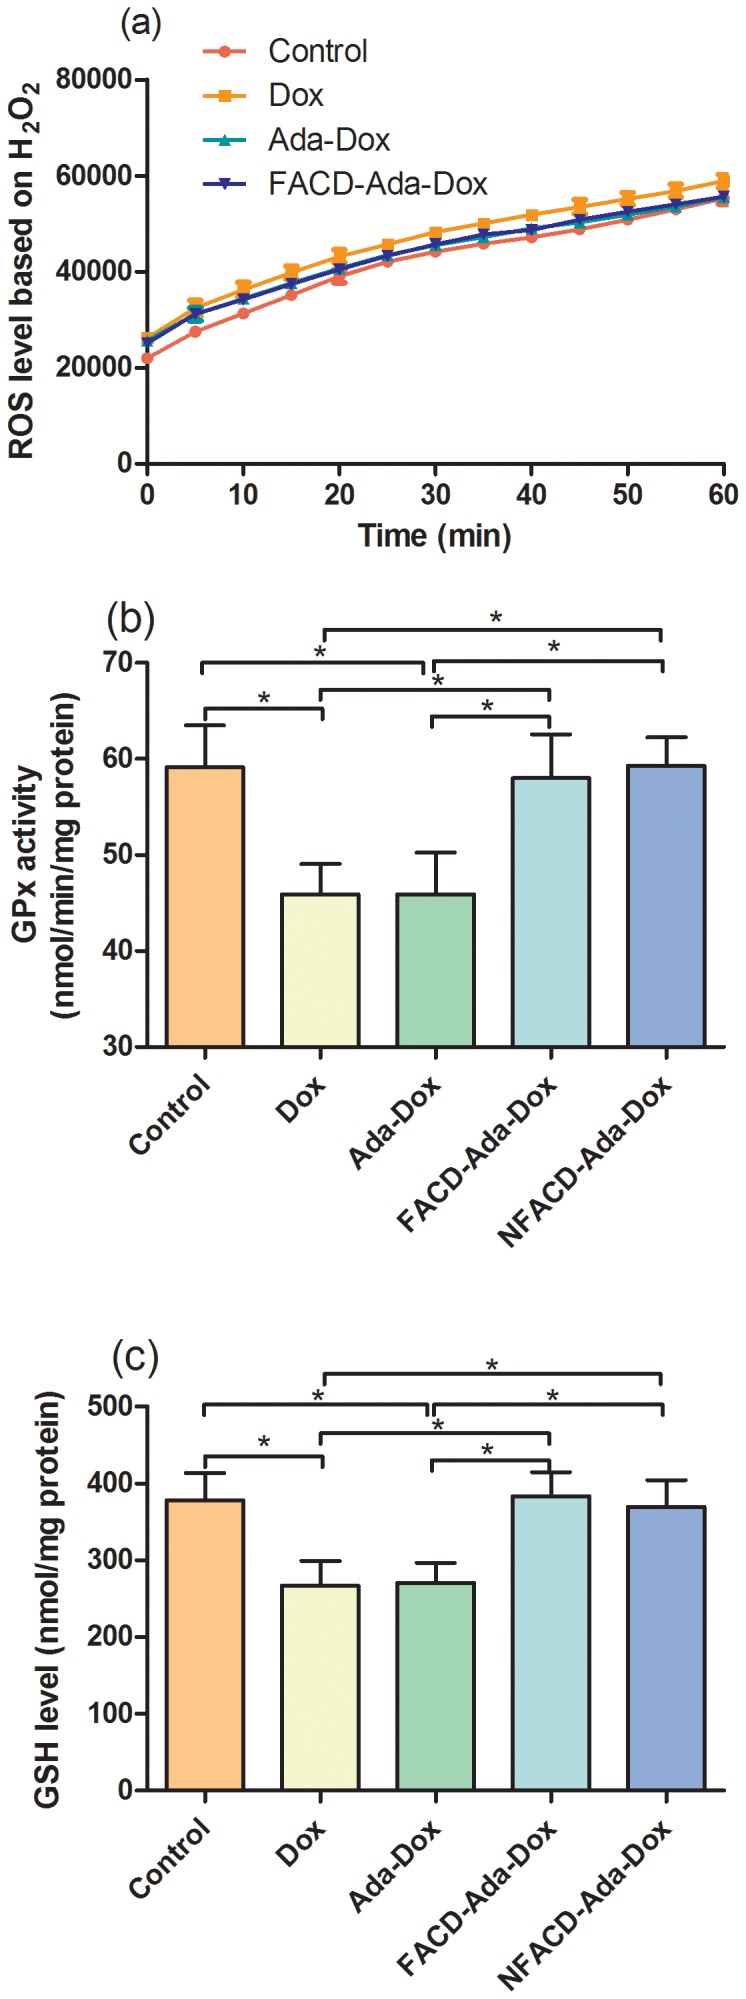
Determination of intraceullar ROS, GPx and GSH levels in mouse 3T3 cells.Plot a shows the level of intracellular ROS in 3T3 cells treated with Dox, Ada-Dox or FACD-Ada-Dox at 5.0 µM over 60 min at 37°C in the culture media. Cells were treated with CM-H2DCFDA. Plot b displays the activity of GPx in 3T3 cells in the presence of Dox, Ada-Dox or FACD-Ada-Dox at 5.0 µM. Plot c shows the GSH concentrations (expressed as nmol/mg protein) in 3T3 cells in the presence of Dox, Ada-Dox or FACD-Ada-Dox at 5.0 µM. Values are the mean ± SD of three different homogenates of cells analyzed in triplicate. *
P<0.05; **
P<0.01; and ***
P<0.001.